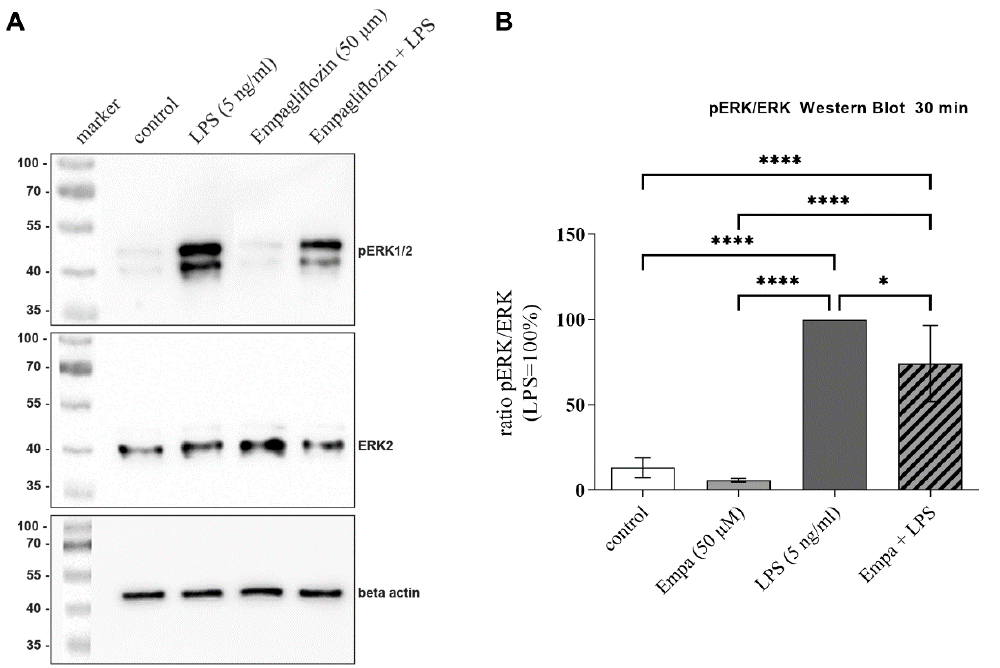
Figure 6. Phosphorylation of ERK1/2 was measured using Western blot after stimulation for 30 min ( A ). Beta-actin was used as the loading control. Bands are identified by their molecular mass based on markers. Quantification of band intensities of ERK2 and pERK1/2 and calculation of pERK/ERK ratio ( B ). LPS activation of microglia caused a strong increase in pERK1/2 levels. Through simultaneous incubation with empagliflozin, LPS-induced phosphorylation of ERK1/2 was significantly decreased by 25.76% (asterisks indicate all significant differences; * p ≤ 0.05, **** p ≤ 0.0001; one-way ANOVA, followed by Tukey test; F-value = 63.75; n = 4).